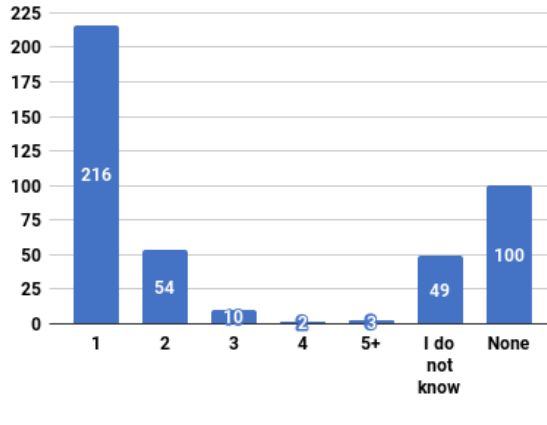
Figure 3. Qty. of ethics content.